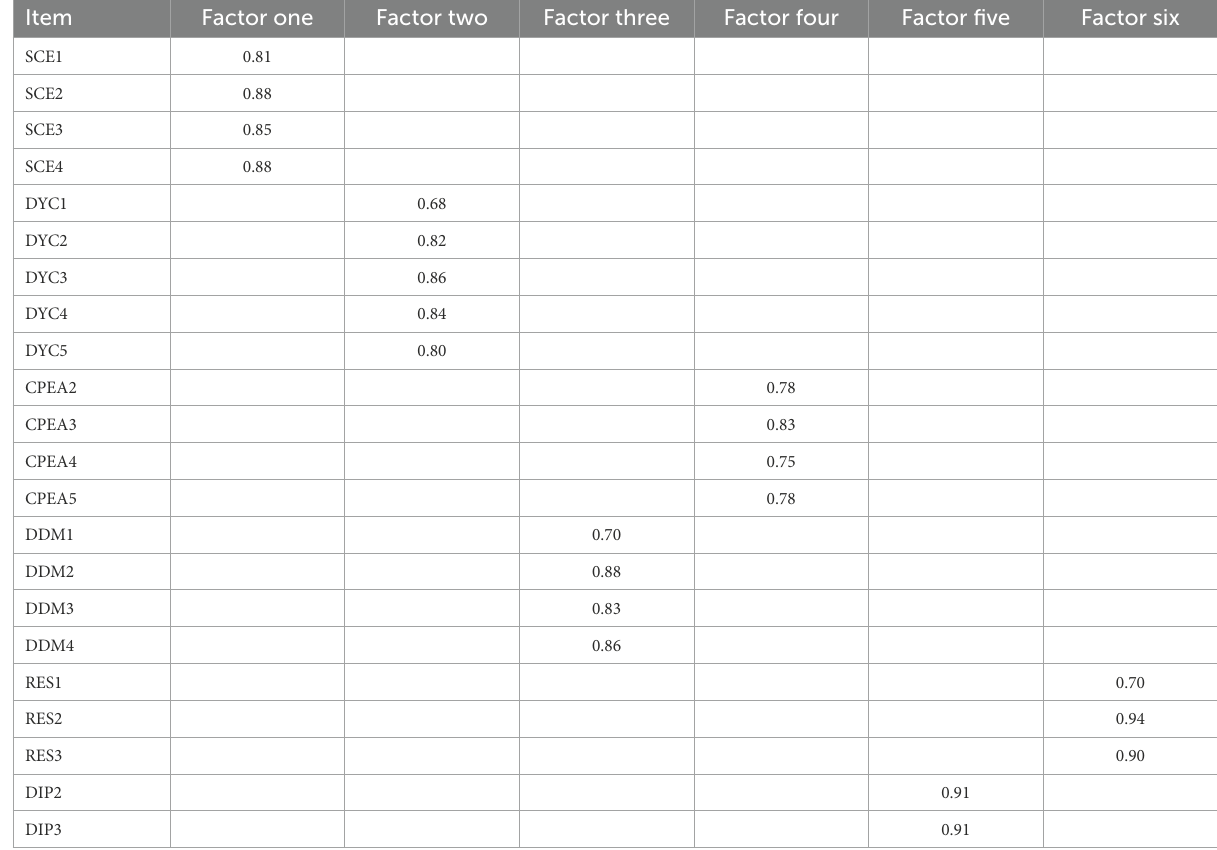
TABLE 4 Result standardized values of the AFC regression SX scale.